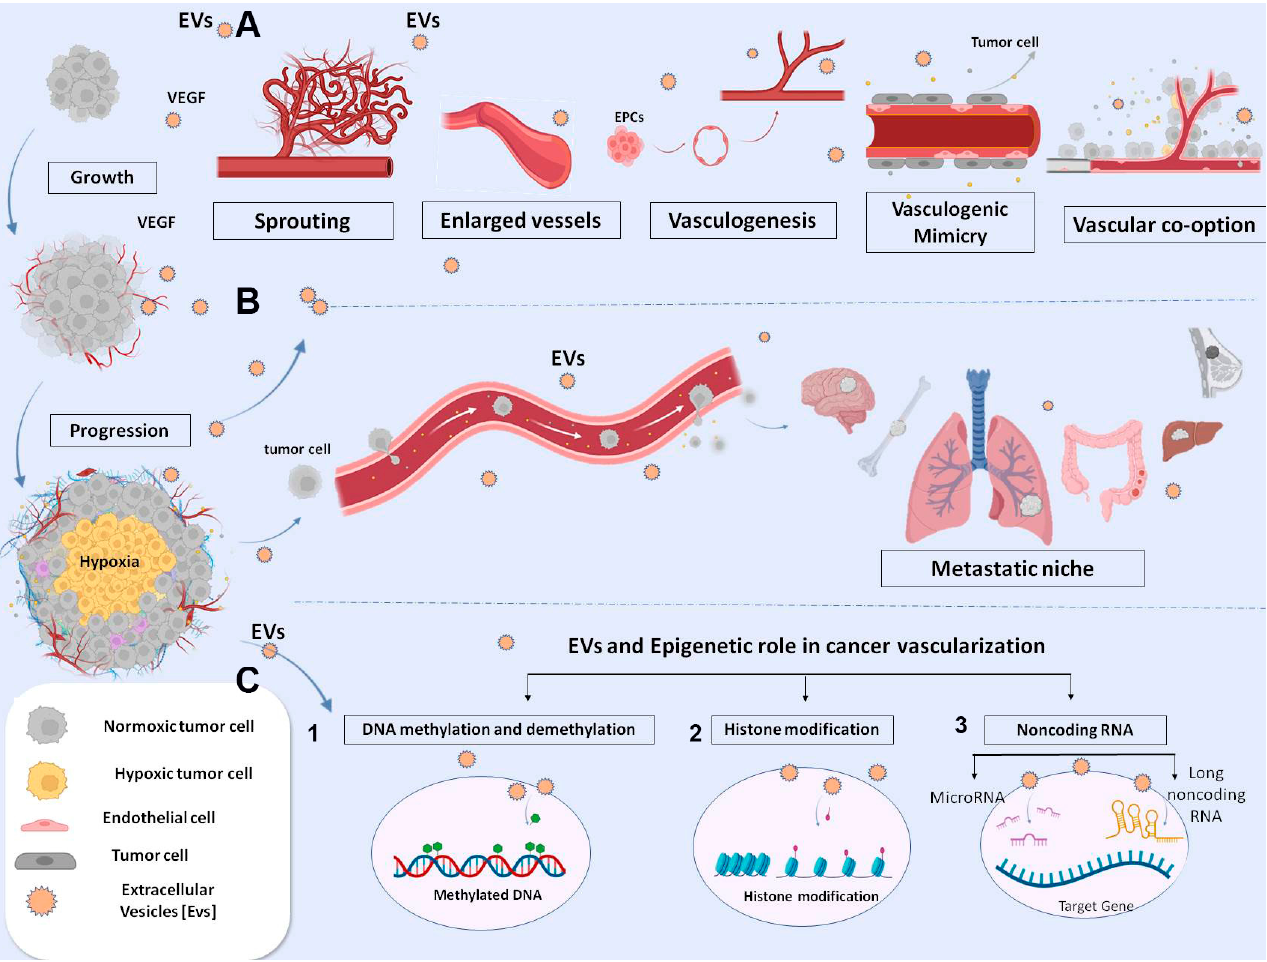
Figure 2. Schematic representation of EVs involved in different mechanisms of tumor angiogenesis. Tumor cell-derived exosomes carrying biological molecules are involved in various angiogenic mechanisms: ( A ) sprouting angiogenesis, vessel enlargement, arteriogenesis, vascular mimicry and vessel-cooption favoring tumor growth and pre-metastasis niche formation; ( B ) Exosomes from malignant cells released locally or at distant sites can induce vessel modifications, with endothelial damage favoring intravasation. Triggering endothelial-mesenchymal transition, which favors endothelial migration at the distal site. Stimulation of extravasation at distant pre-metastatic niche; and ( C ) Schematic representation of epigenetic mechanisms: 1 DNA methylation; 2 Histone modifications; 3 non-coding RNA targets intracellular mRNA.